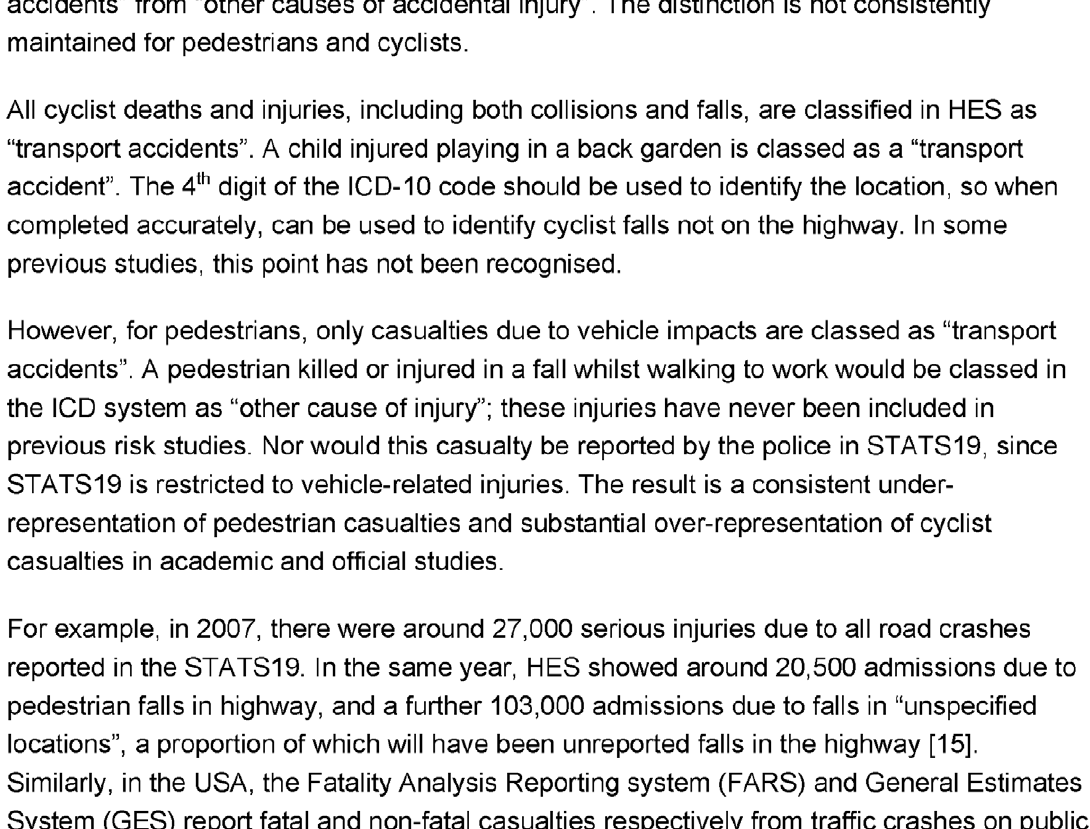
Figure 1. Sources of data on transport injuries and fatalities.